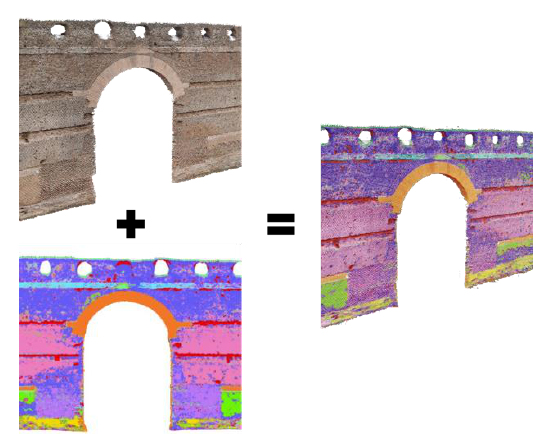
Figure 1: Schematic representation of the segmentation method.